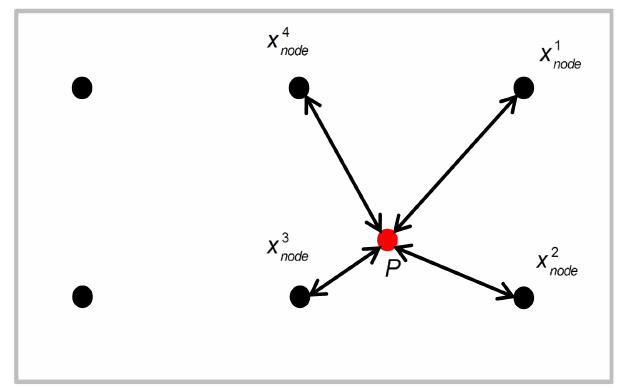
Figure 2. A case showing an IDW tomography model in a certain layer. Black points are voxel nodes used for predicting the value of the pierce point (red point); the gray wireframe indicates the layer used in the model, and the length of the double arrows represents the distance between the point P and voxel node x (cid:48) node